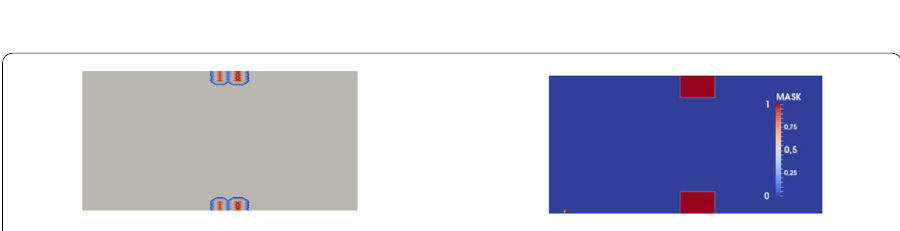
Fig. 5 On the left, the level set function with two obstacles on the lower and upper walls situated respectively at the same position of the above ones, but with a new intermediate length and two different widths. On the right, a mask vector describing the restricted fluid domain (cid:2) R of the new solution by the red color, and the unknown flow field data zone by the blue color